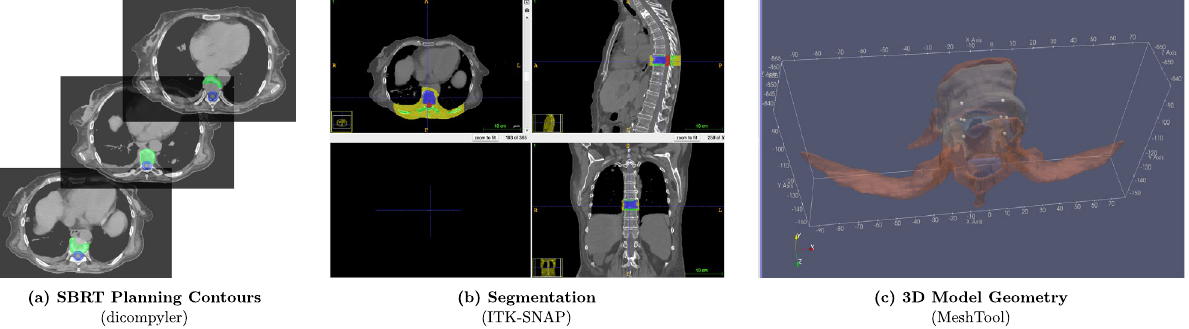
Figure 1. Overview of PDT treatment planning framework for a female patient with a metastatic T8 sclerotic lesion: ( a ) extraction of contours from stereotactic body radiation therapy plan using the Dicompyler tool, including the clinical target volume or metastasis (green) and spinal cord (blue), ( b ) segmentation of the original CT dataset using ITK-SNAP to delineate the metastasis (purple), normal bone (green), spinal cord (red), and muscle (yellow) at the T8 level, ( c ) generation of the 3D mesh geometry using MeshTool for light dose simulation with FullMonte Methods.